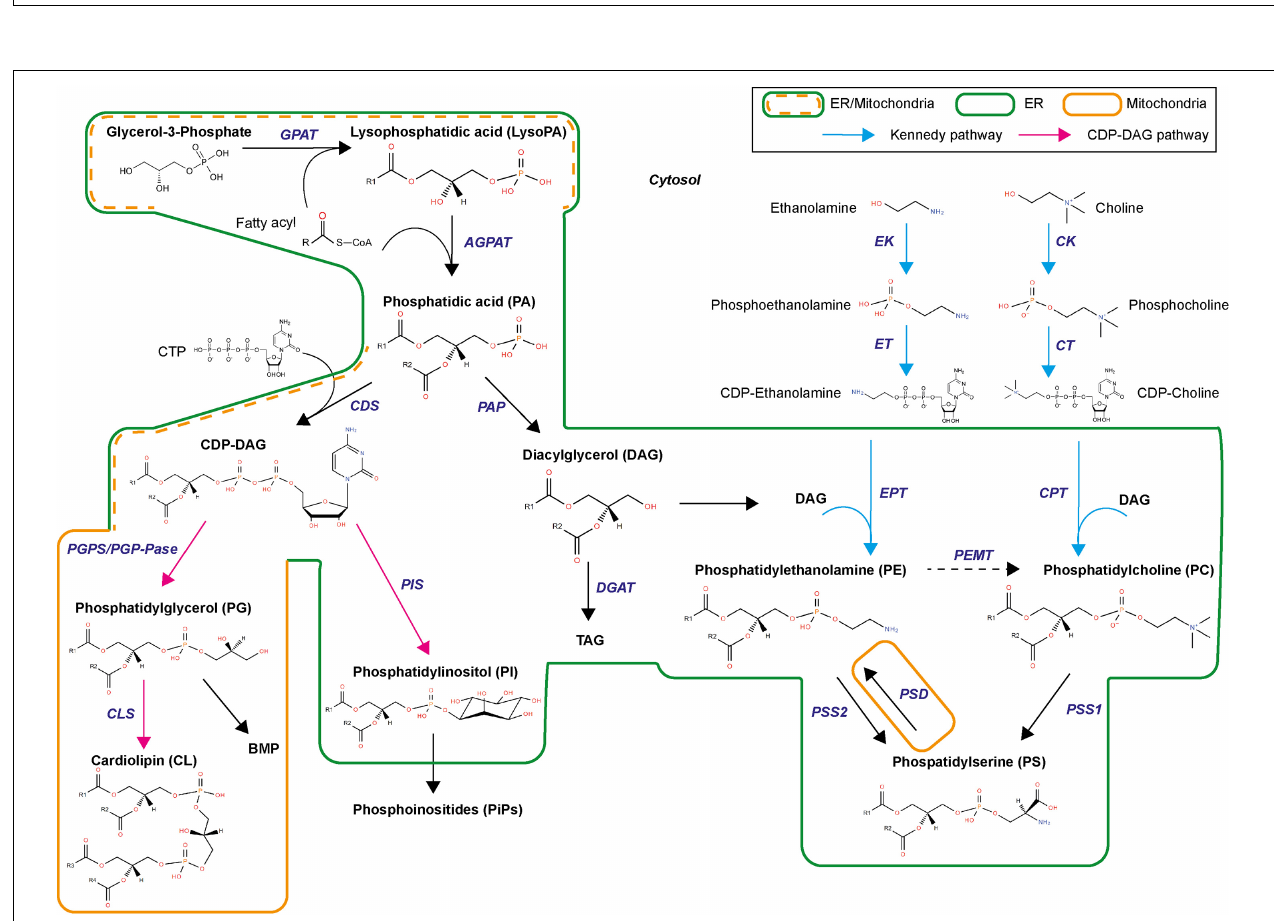
Frontiers in Physiology |